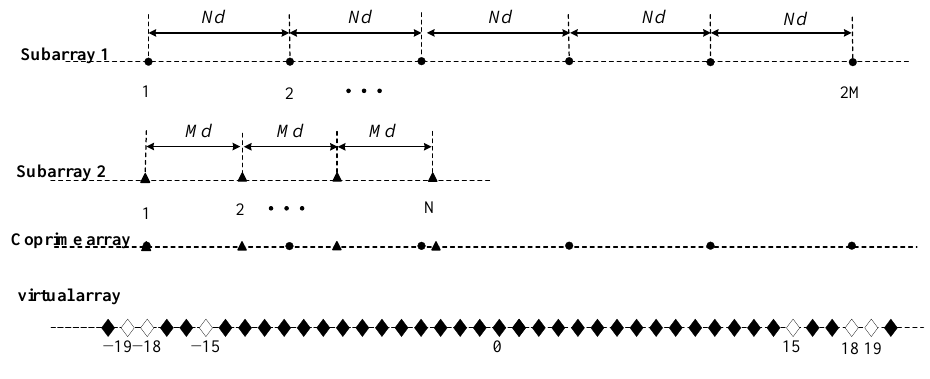
Figure 5. Schematic diagram of the extended coprime matrix combined with M = 3, N = 4 . It can be seen from Figure 5 that the obtained virtual array is not continuous and the uniform linear subarray composed of (2𝑀𝑁 + 1) virtual array elements from −𝑀𝑁𝑑 to 𝑀𝑁𝑑 positions in the virtual array.